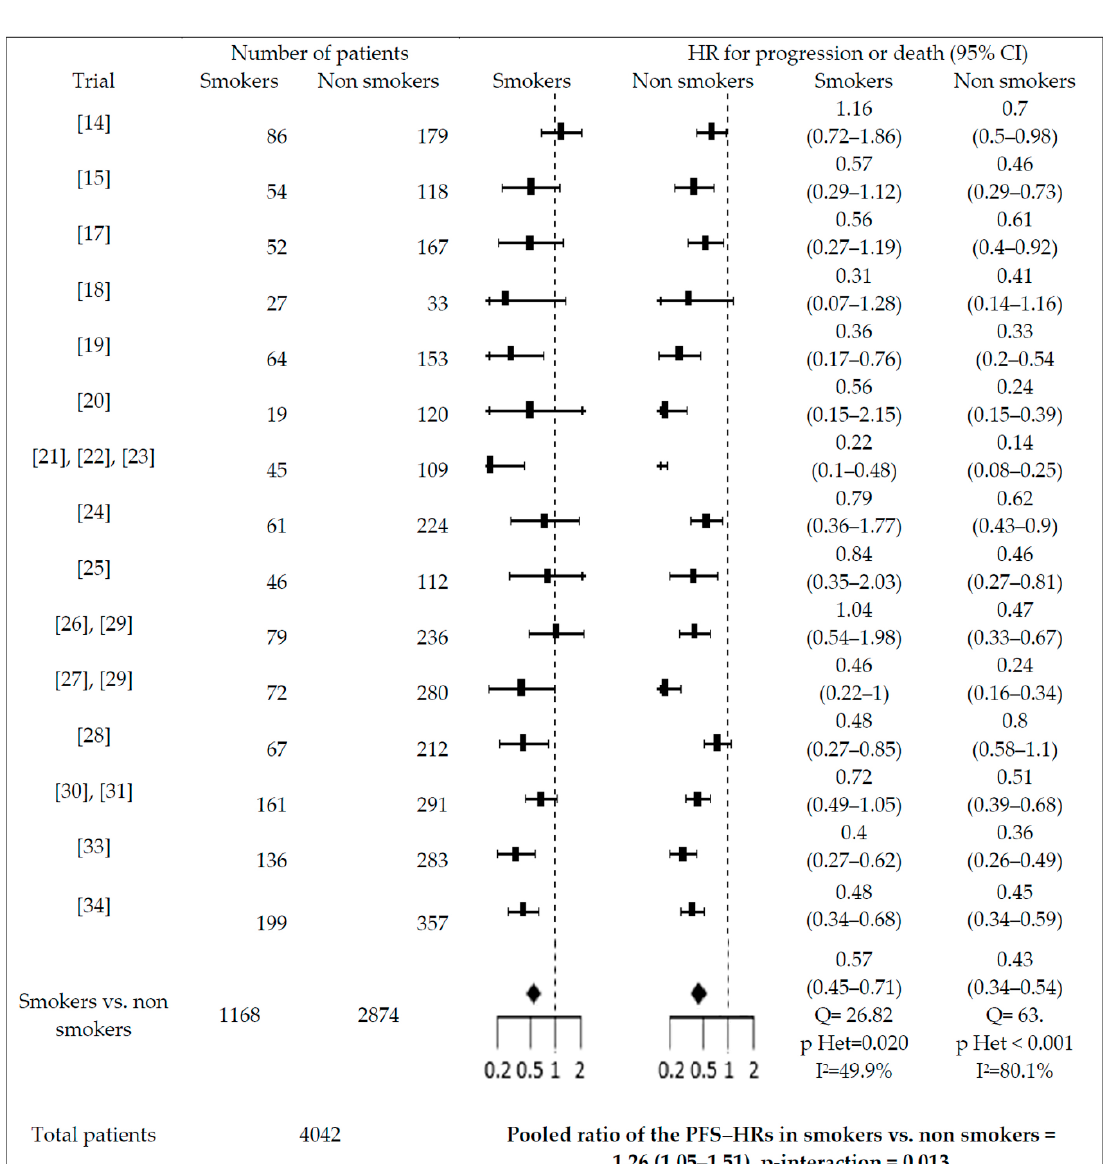
Figure 5. Interactions between PFS-HR and smoking history. PFS-HRs are separately reported for smokers vs. non-smokers. Pooled PFS-HRs in smokers vs. non-smokers and pooled ratio of the PFS- HRs in smokers vs. non-smokers are reported at the bottom of the figure.